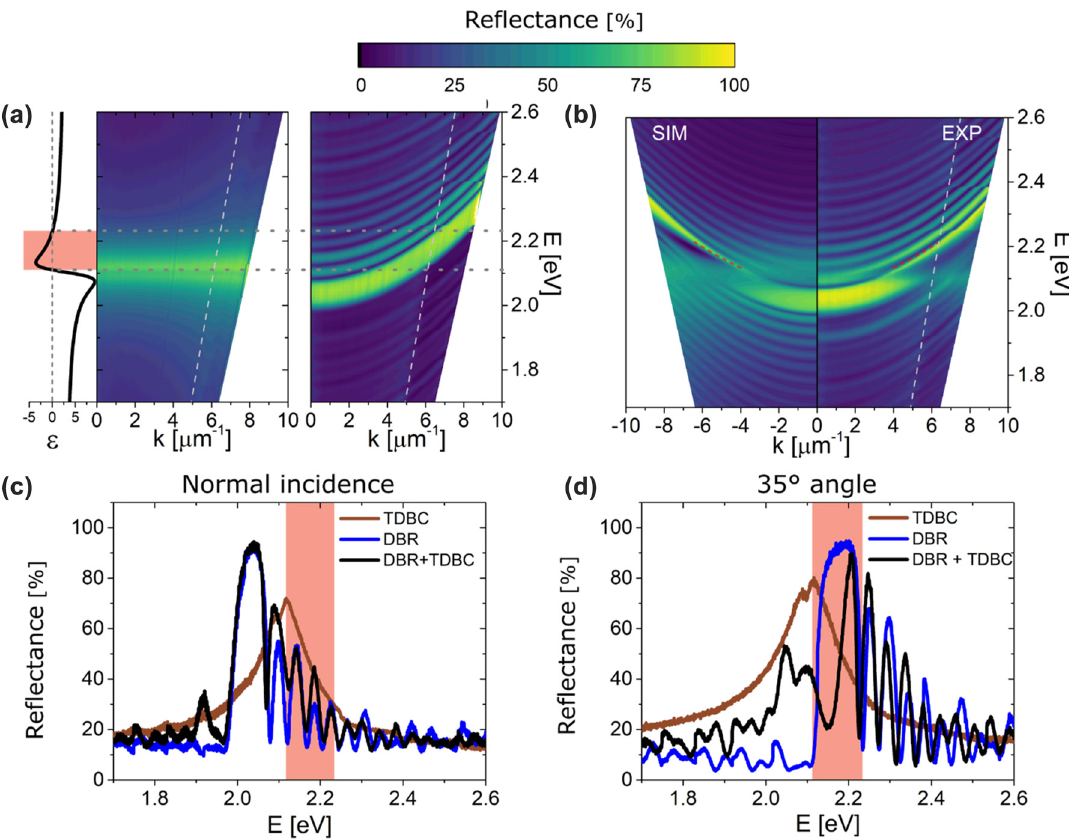
Figure 2: Reflectance measurements. Experimentally measured angle-dependent absolute reflection spectrum (all s polarised) of the fabricated structure with Δ = 196 nm. (a) Thin TDBC-PVA film (left) and the DBR (right). To the left, the real permittivity is shown for reference. (b) The reflectance of OTS structure with Δ = 196 nm: simulation (SIM) and experimental (EXP). Red dashed lines show the solution of the OTS from Equation (S8) in SI. The wave vector at 𝜃 = 35 ◦ incidence angle is given by k = 𝜔 / c .sin( 𝜃 ) and represented by a dashed grey line. Cross-sections of these plots at normal incidence (c) and 𝜃 = 35 ◦ (d). The orange-shaded region represents the metallic-like area of TDBC-PVA where an OTS can occur.